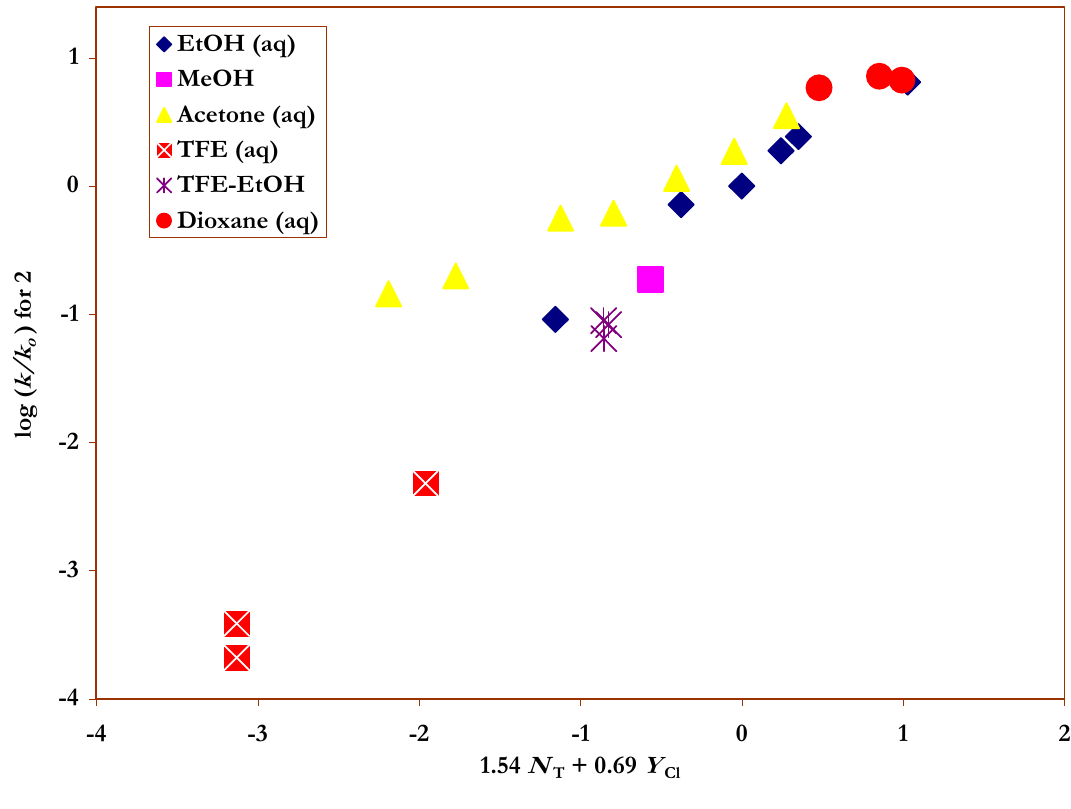
Figure 3. The plot of log ( k/k benzenesulfonyl chloride ( 2 ) in pure and binary solvents at 35.0 ºC. Four acetone-water points (90% - 75%) were not included in the correlation but are added to show the extent of their deviations from the